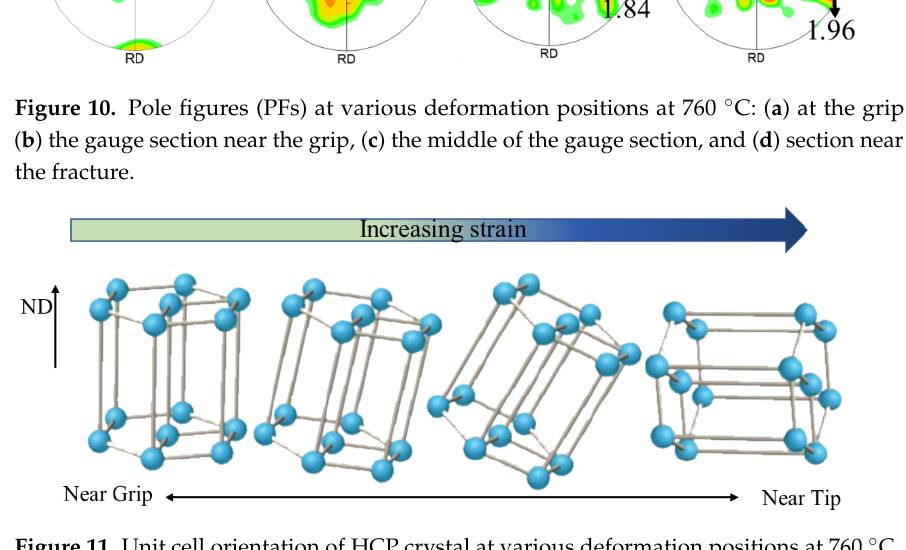
Figure 11. Unit cell orientation of HCP crystal at various deformation positions at 760 °C. Table 3. The fraction of LAGBs at different positions in the tensile test specimen. Before